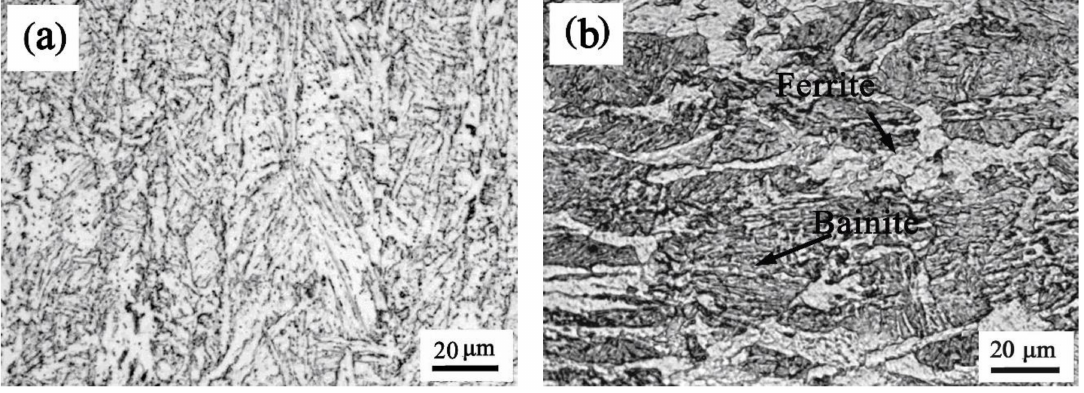
Figure 10. The microstructues of sample #2 cooled by t 8/5 ( a ) 30 s and ( b ) 60 s, respectively.